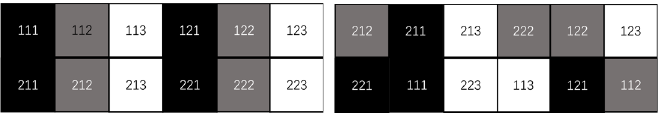
Figure 4. Schematic diagram of pixel position before and after scrambling.